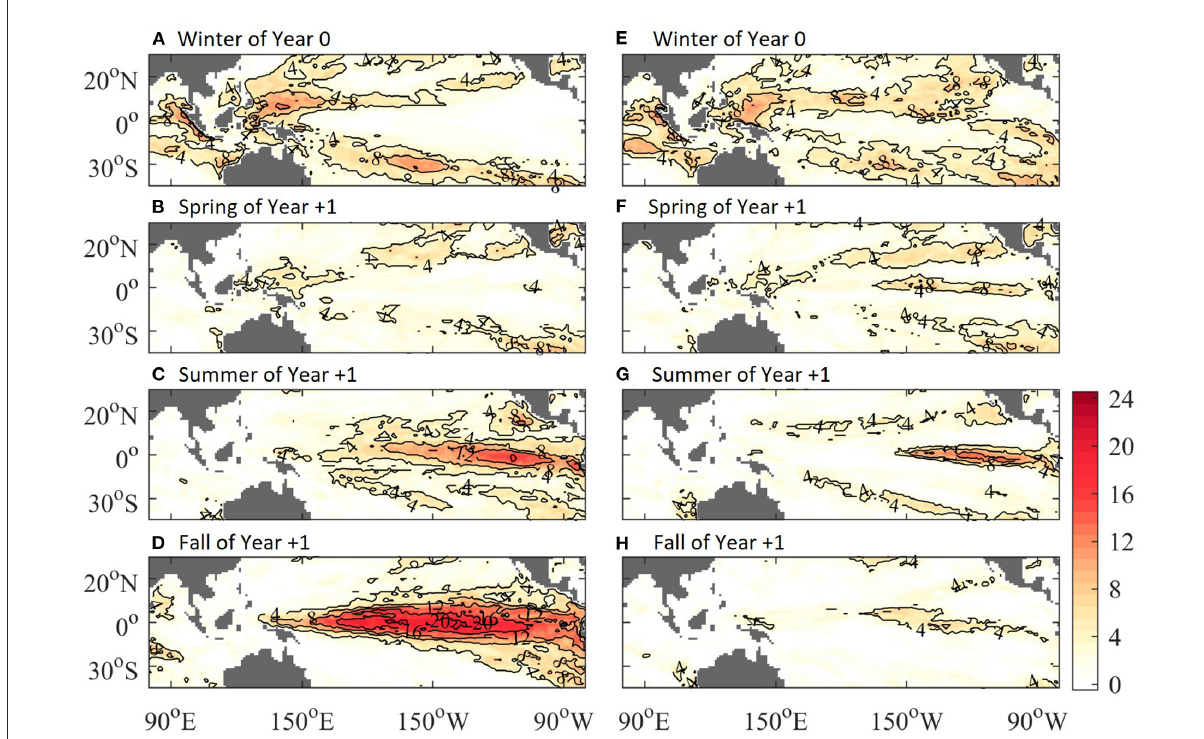
FIGURE4 Numbers of CMIP5 models with significant positive correlations between the STIO SSTA in fall and the tropical Indo-Pacific Oceans SSTA in (A) winter of Year + 0, (B) spring of Year + 1, (C) summer of Year + 1, and (D) fall of Year + 1. (E–H) are same as (A–D) , but with the ENSO signal